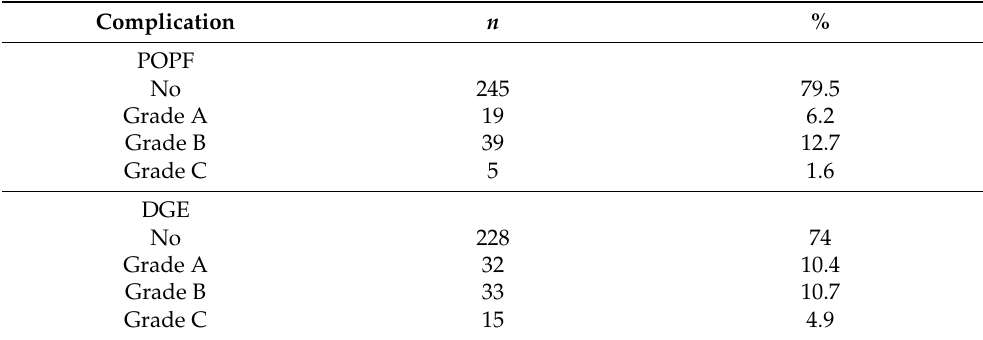
Table 2. Postoperative complications in